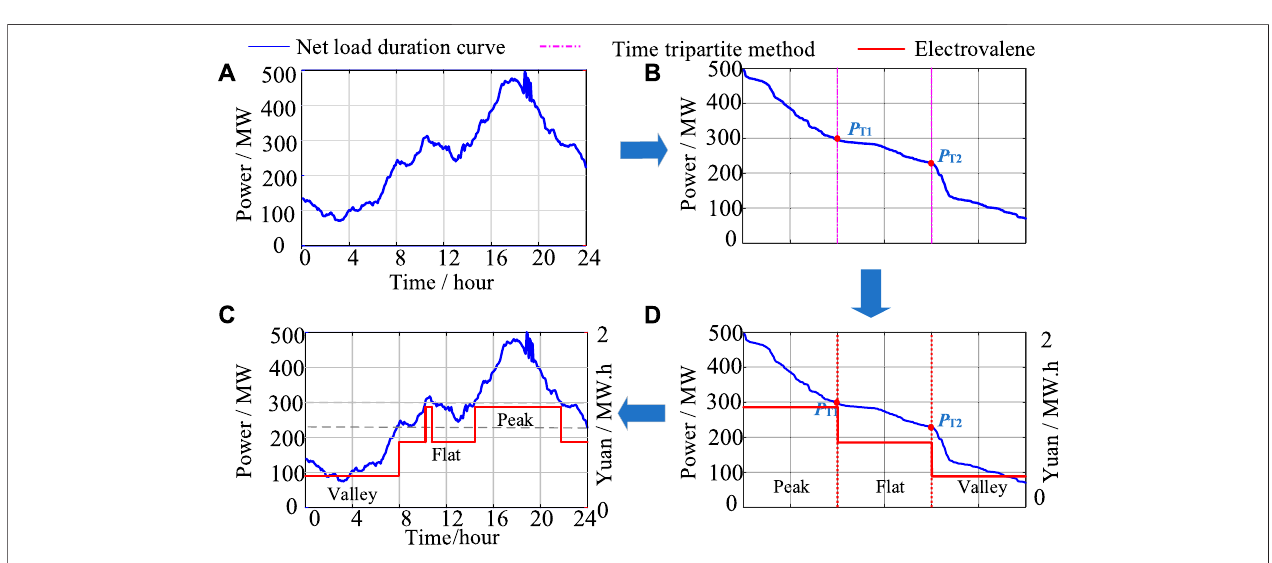
FIGURE 4 | Dynamic electricity price-setting method of time